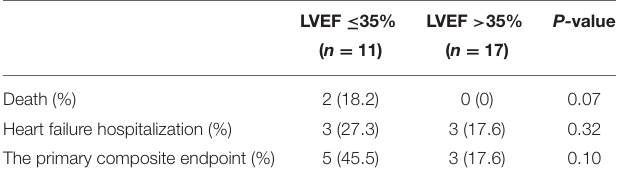
TABLE 3 | Clinical endpoints in successful LBBAP patients at the 12-month follow-up.